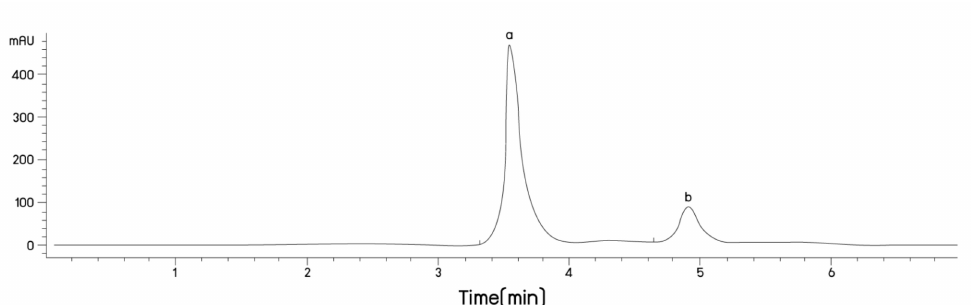
Figure 1. HPLC analysis of C3G and P3G in PRBF product. Plasma-treated Riceberry™ rice flour (PRBF) was analyzed using the HPLC conditions described in Section 2.3. Two major compounds, cyanidin-3-glucoside (C3G) (peak a) and peonidin-3-glucoside (P3G) (peak b), were detected at 510 nm and identified by comparison with the retention times of the two standards and the concentrations in terms of mg anthocyanin equivalent (AE) were